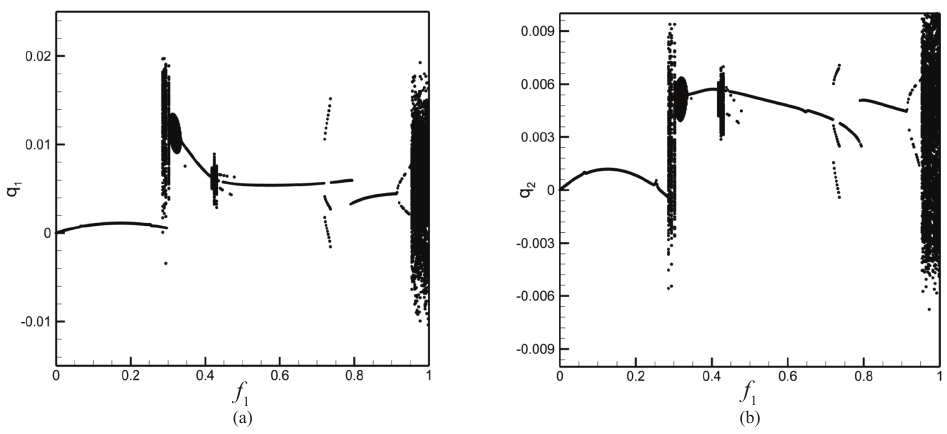
Fig. 11. Bifurcation diagrams of Poincaré points for increasing forcing amplitude on the system with c = 1 ,α = 10 and β = 2